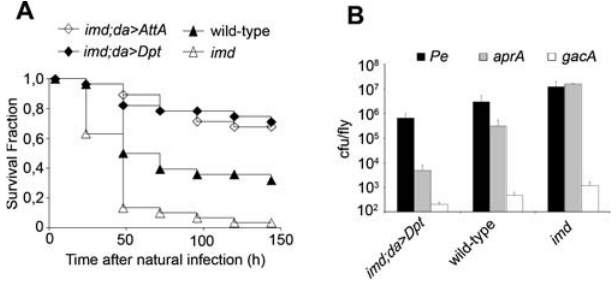
Figure 6. AprA Confers Protection against Diptericin (A) imd flies over-expressing Diptericin or Attacin A show increased resistance against P. entomophila infection. Survival rates were moni- tored on imd mutants, wild-type, and imd ; UAS-AMP flies orally infected with P. entomophila (OD 600 ¼ 25). The genotypes of the utilized flies are: imd : imd / imd ; wild-type: imd/ þ ; da-Gal4/ þ ; imd; da . AMP: imd , UAS-AMP / imd ; UAS-AMP / da-GAL4 . Log-rank analysis demonstrated a statistically significant difference in survival of imd ; UAS-AMP flies and wild-type flies to P. entomophila oral infection ( p , 0.01). (B) Persistence of wild-type P. entomophila and aprA mutants in imd flies over-expressing Diptericin under the control of the da-Gal4 driver. aprA mutants persist less than wild-type P. entomophila in lines over- expressing Diptericin in contrast to flies mutated in the imd locus. The number of cfu per fly represented in each histogram corresponds to the average of six independent experiments ( 6 standard deviation). cfu, colony-forming unit. DOI: